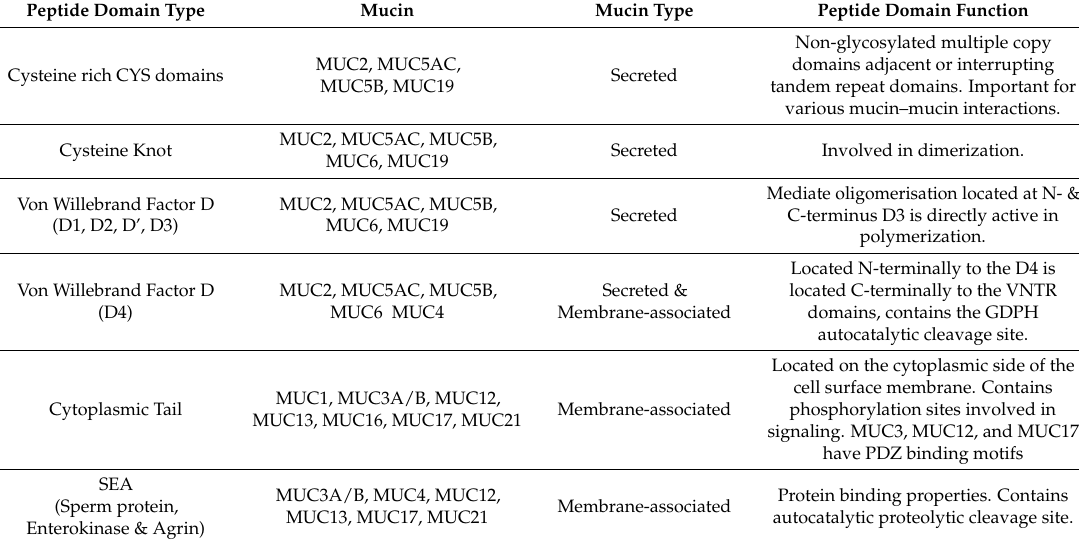
Table 2. Mucin peptide